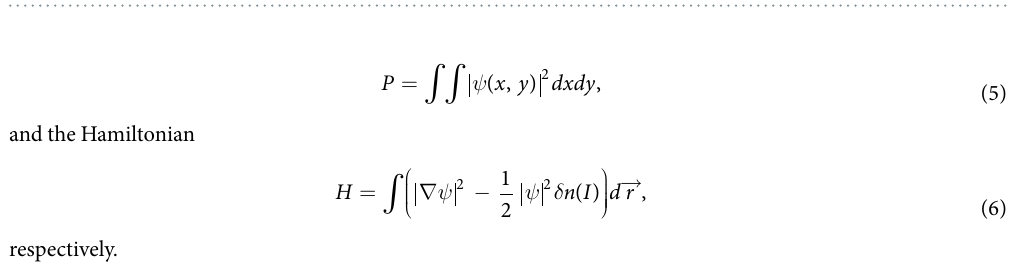
Figure 9. The intensity distributions of outward accelerating abruptly autofocusing Airy beam at different propagation distances in ( a – c ) local ( σ = 0), and ( d ) nonlocal nonlinear media, respectively. The initial parameters are m = 1, r 0 = 5, A = 0.5 ( a , b ), and A = 2 ( c , d ). The degree of nonlocality of Fig. 9(d) is σ =